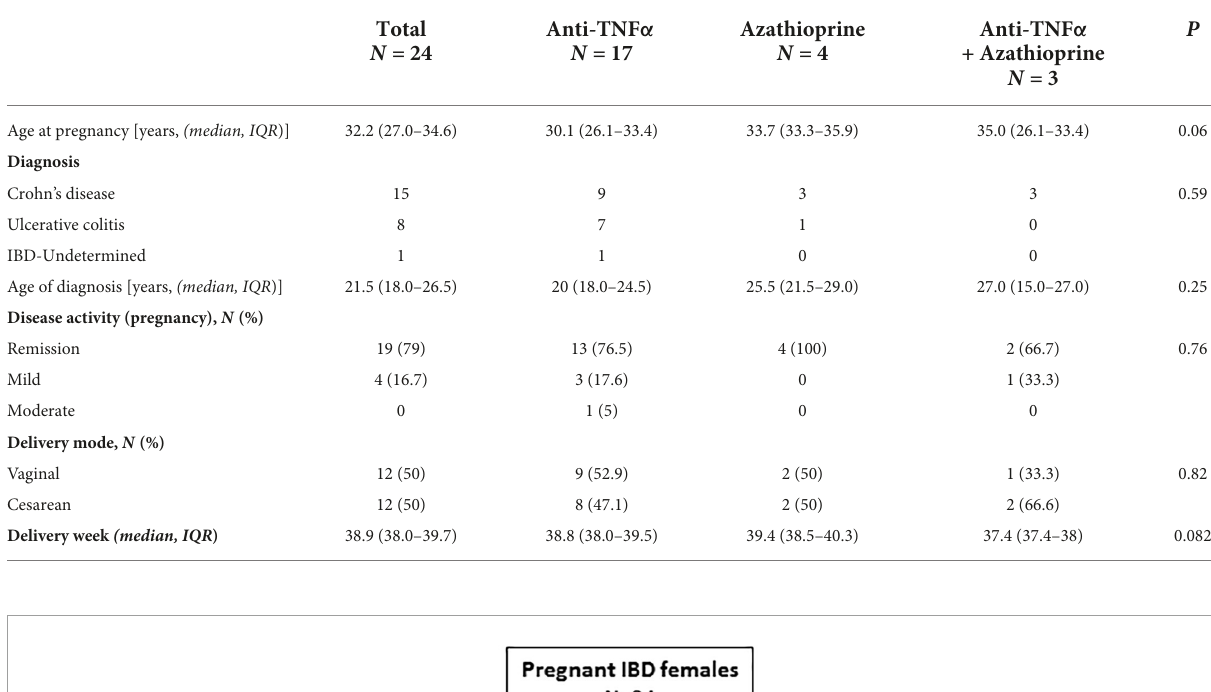
TABLE 1 Demographic and clinical characteristics of the study group.